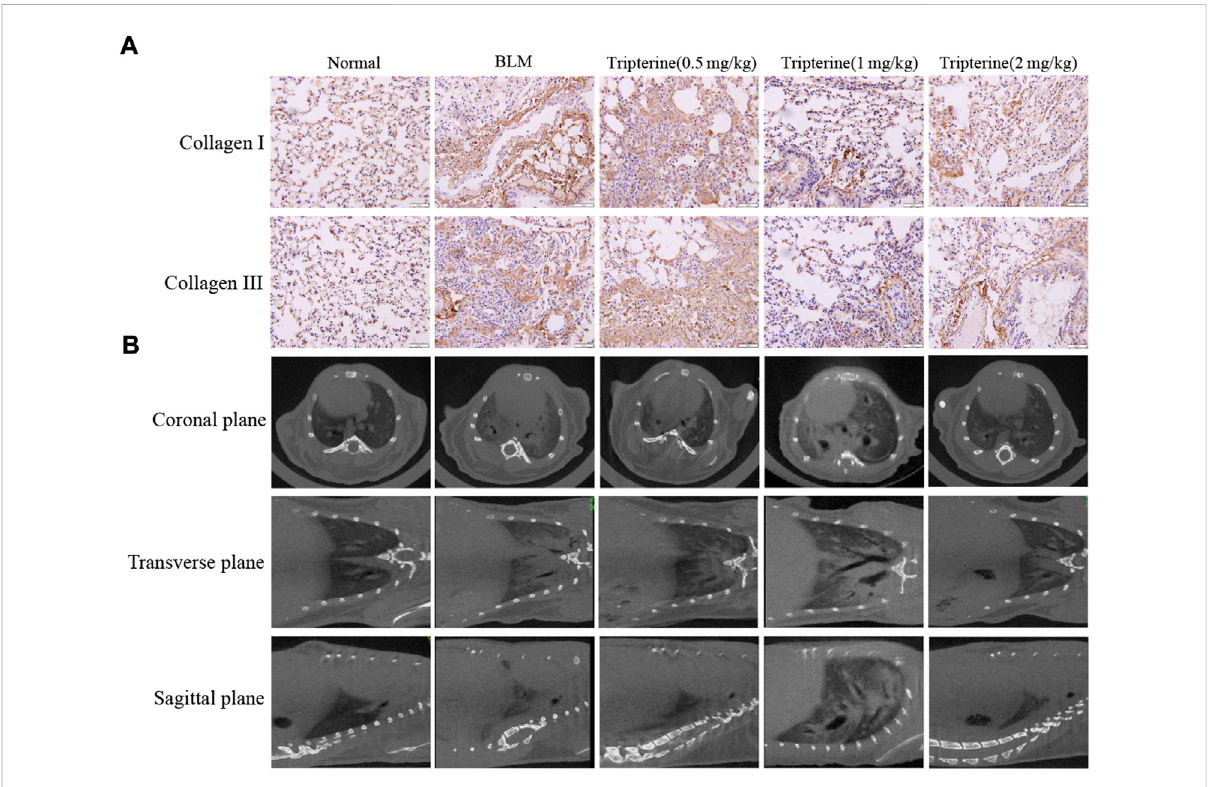
FIGURE 6 Deposition of collagen I and III and micro-computed tomography (CT) fi ndings in mouse lungs. (A) Collagen I and III depositions in the lung tissues of mice after tripterine treatment. (B) Micro-CT fi ndings of the lungs in mice treated with tripterine. Scale bars: 50 μ m. Results are presented asthemean±standarderrorofthemean.### p < 0.001vsthenormalgroup;* p < 0.05,** p < 0.01,and*** p < 0.001vs.theBLM-treatedgroup.BLM, bleomycin (5 mg/kg); Trip,